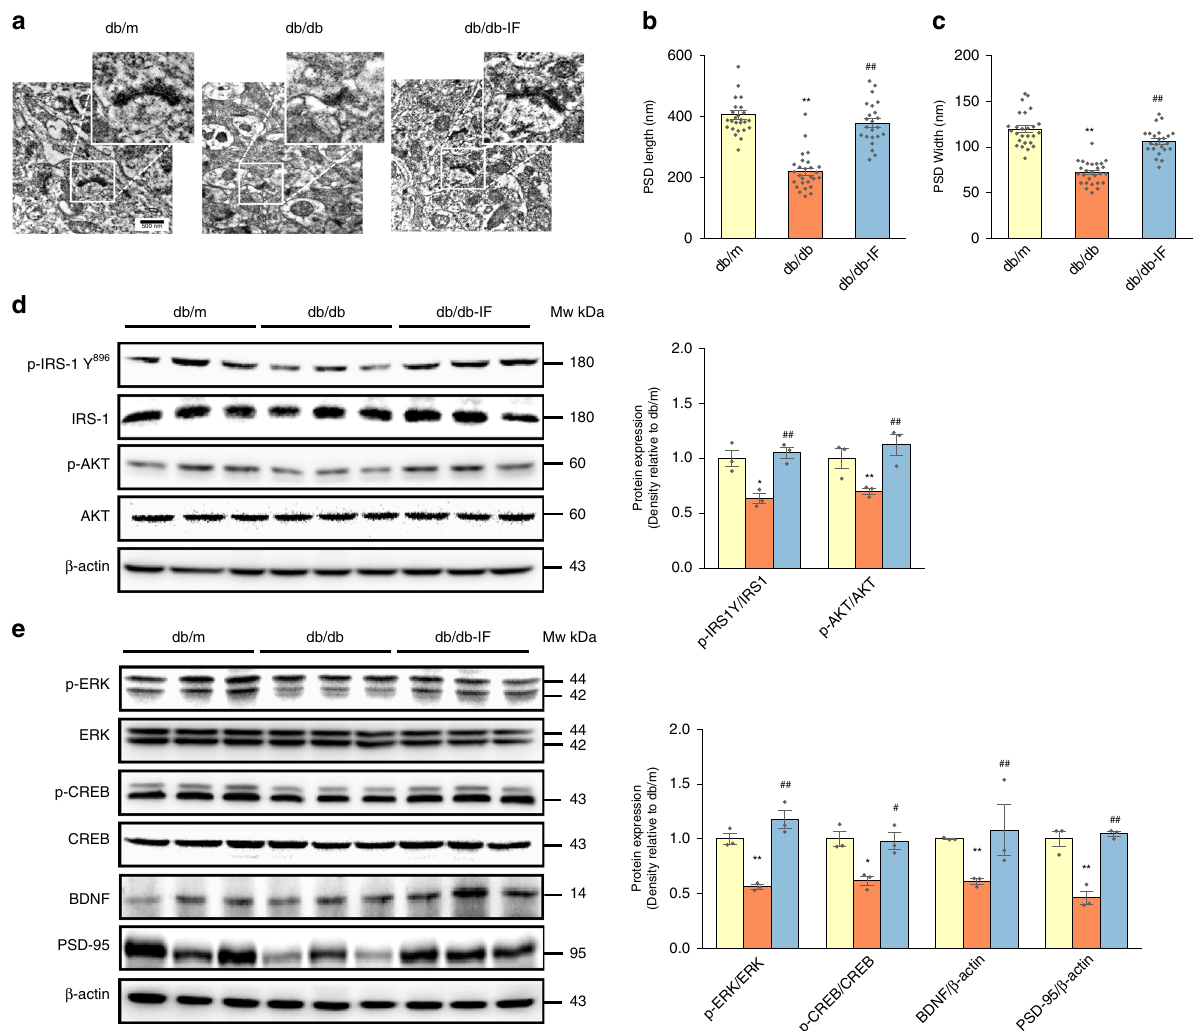
Fig. 2 Intermittent fasting improved synapse ultrastructure and altered IRS/Akt and CREB/ERK signaling in db/db mice brain. a Representative images of ultrastructure of synapse. b , c The length and width of PSD ( n = 6 slices per group). d , e Western blots analysis of hippocampal IRS/Akt and CREB/ERK related signaling ( n = 3 mice per group). Data presented as mean ± SEM. * p < 0.05, ** p < 0.01, compared with db/m group, # p < 0.05, ## p < 0.01 compared with the db/db group. Signi fi cant differences between mean values were determined by one-way ANOVA with Tukey ’ s multiple comparisons test. See also Supplementary Fig. 2. Source data are provided as a Source Data fi